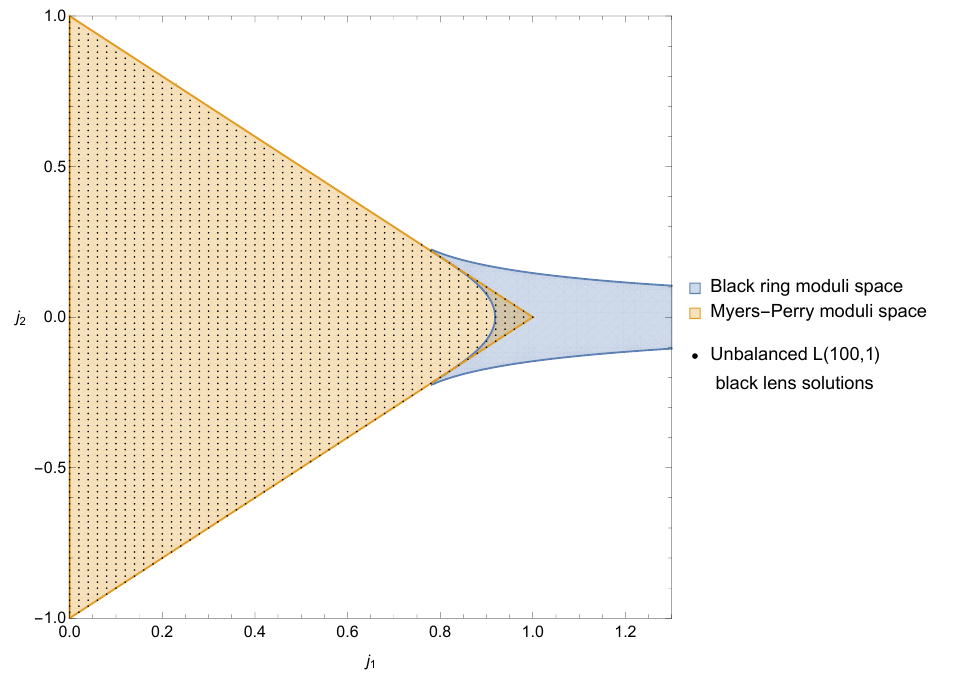
Figure 3 . The unbalanced L (100 , 1) black lens solution projected to the ( j 1 , j 2 ) plane. This closely approximates the Myers-Perry moduli space, consistent with the analysis in section